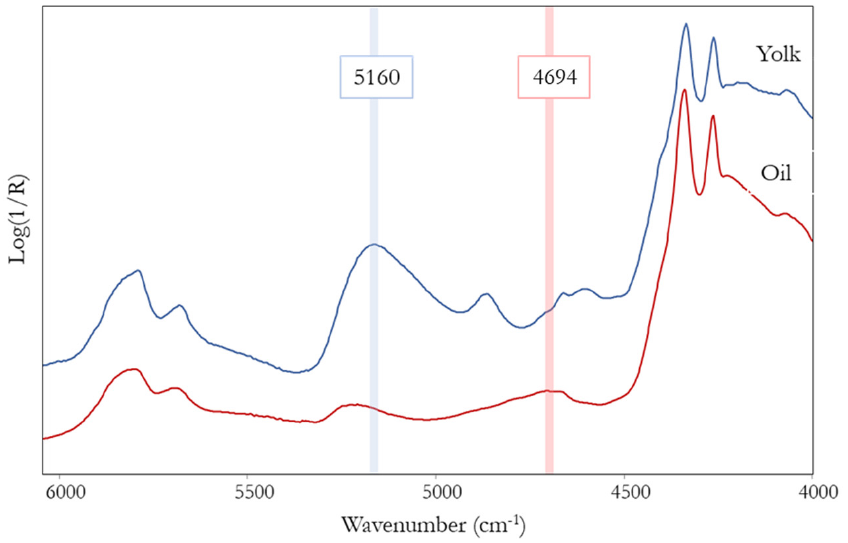
Figure 7. Highlighting of the absorption bands at 4694 and 5160 cm − 1 typical of oil and egg yolk, respectively, and chosen for the calculation of the intensity ratio used to distinguish the two binders and their possible mixture.